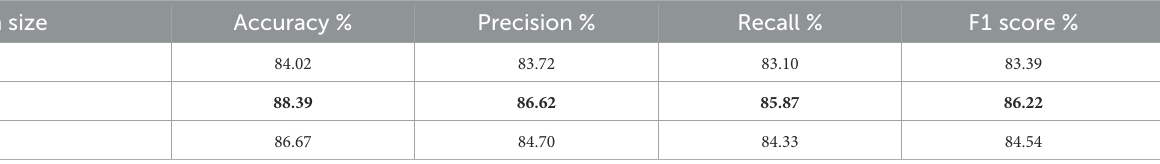
TABLE 5 Average performance results generated by patch size model in tuned parameter CNN. Patch